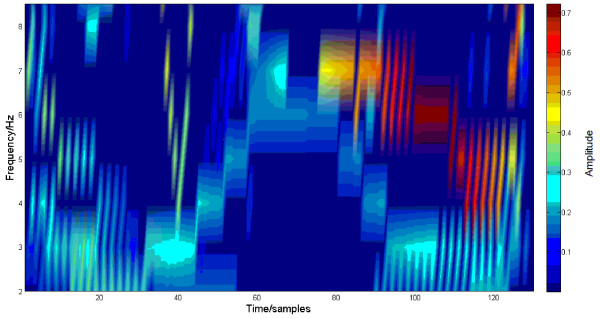
HHT on the trace in Figure 2.